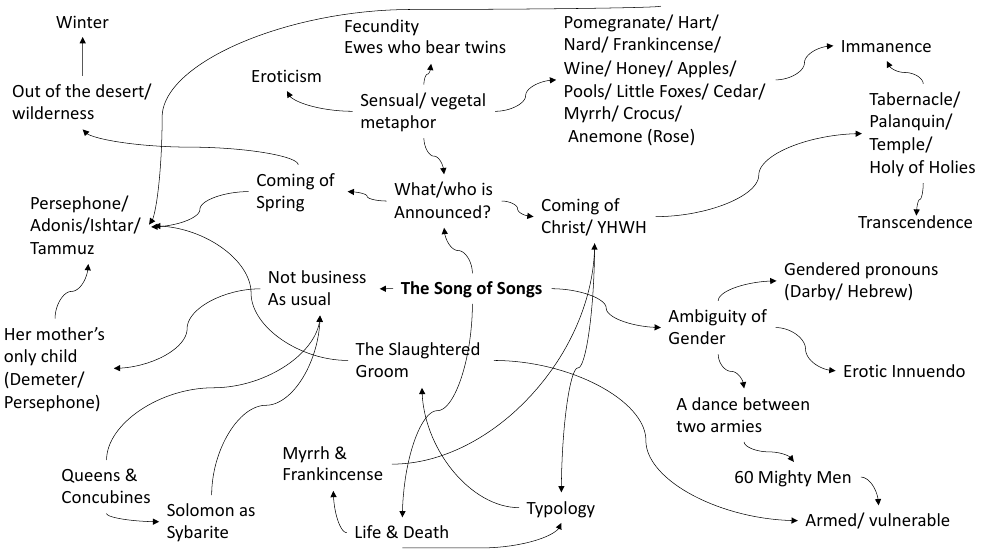
Figure 3. The Song of Songs :themes and